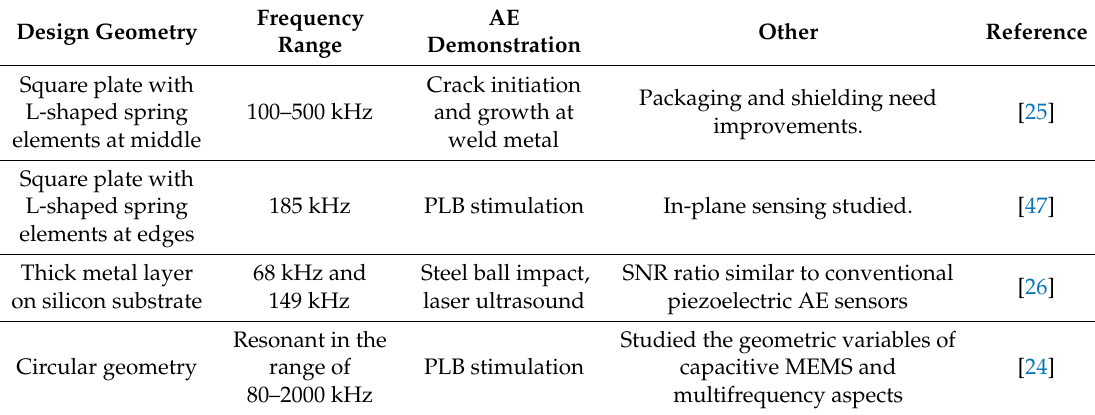
Table 3. Capacitive MEMS AE sensors and their